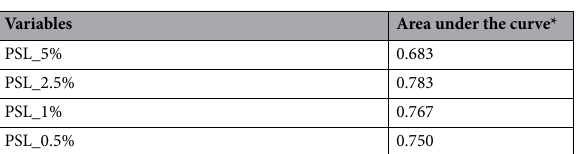
Table 7. Area under the curve for the PSLs at the level of 5%, 2.5%, 1%, and 0.5% PSL, probability score limit in eye movement perimetry. * p value < 0.001.